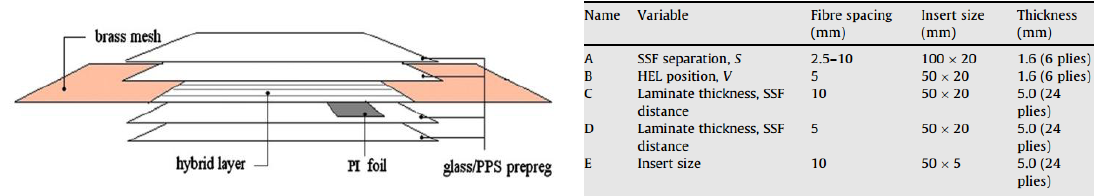
Figure 22. HEL laminates: Schematic lay-up of the HEL laminates and specifications of the different laminates prepared during the experimental campaign, with permission from